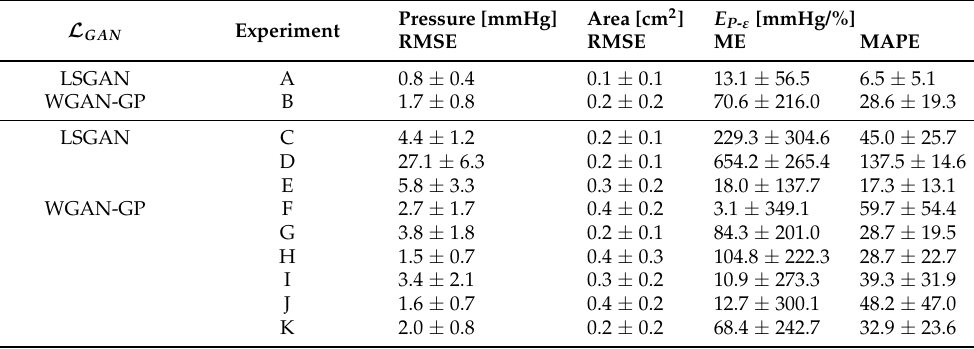
Table A2. Detailed Brachial–Radial to Aortic Abdominal